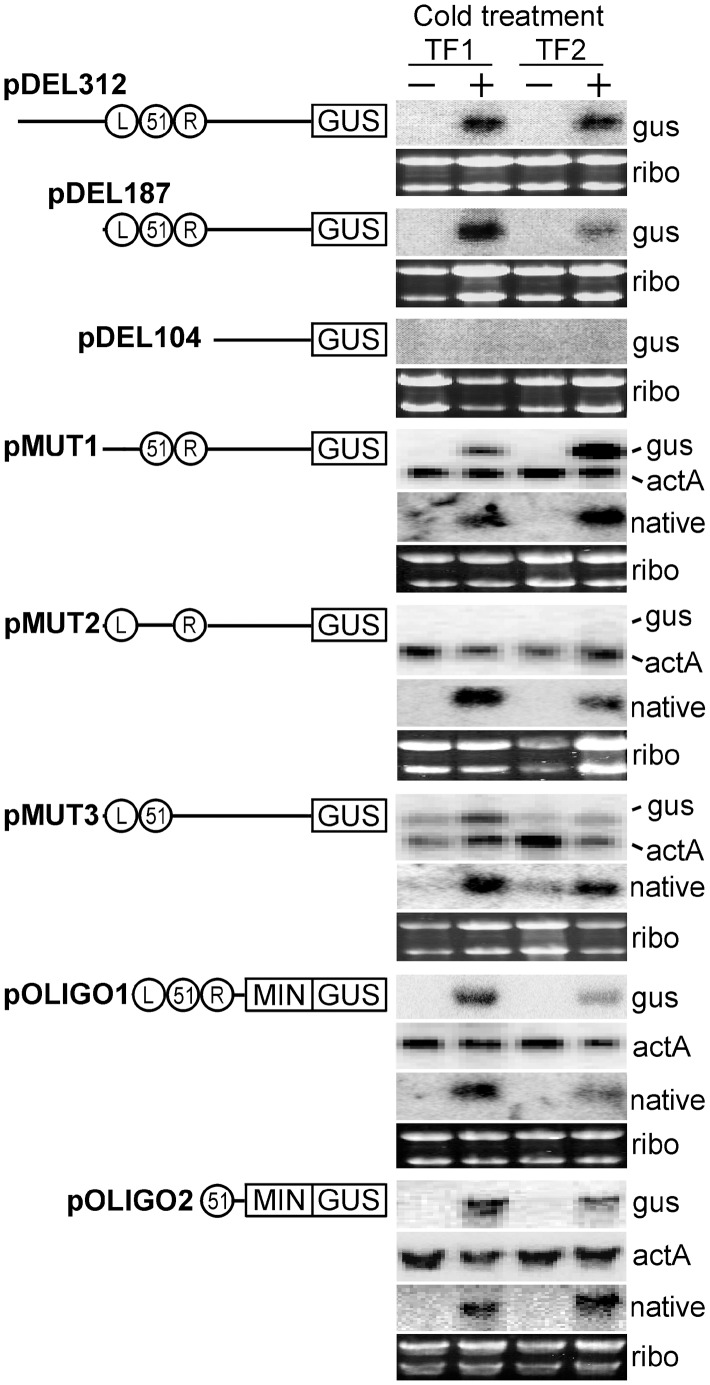
Constructs used to demonstrate function of M51 from promoter PITG_16321.Each contains sequences fused to the GUS reporter, which was transformed into P. infestans. Shown for each construct are results from RNA blot analysis of two representative transformants (TF1, TF2). RNA was extracted from sporangia immediately after harvesting (−) or after a 1-hr cold treatment (+). RNA was hybridized with probes for the GUS reporter (gus), or the PITG_16321 open reading frame to detect the endogenous transcript (native). The top three constructs contained serial 5′ deletions of the wild-type promoter, and the bottom five contained oligonucleotides with the LB, M51, and RB sequences (represented by circles) fused to the minimal NifS promoter (MIN) and GUS. Shown as loading controls are a photograph of rRNA and hybridization with the actA (actin) gene of P. infestans.